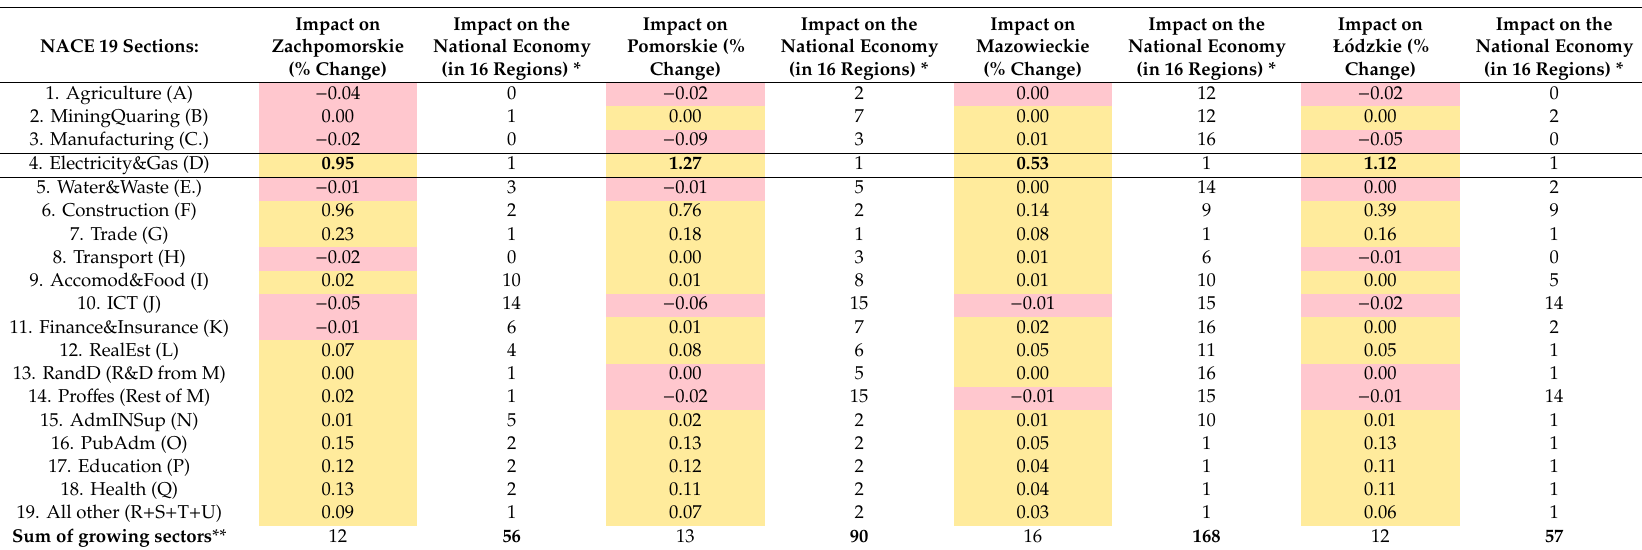
Table A2. Impact of the regional investments in nuclear power plants on sectoral outputs in Poland and location regions, simulation for 2025–2050. NACE 19